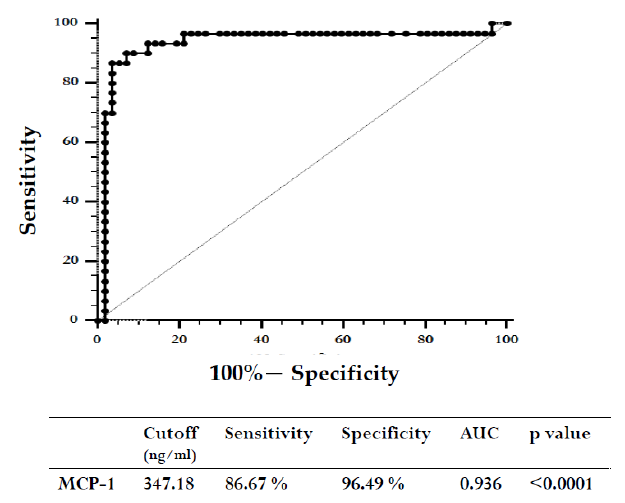
Figure 8. Receiver operating characteristic (ROC) curves for MCP-1 levels in the diagnosis of VAP.